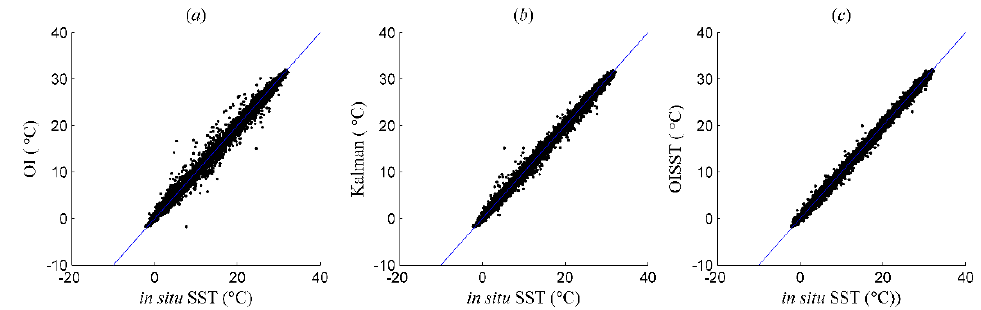
Figure 9. Scatter plots for 2016 from ( a ) OI, ( b ) Kalman and ( c ) OISST results with in situ